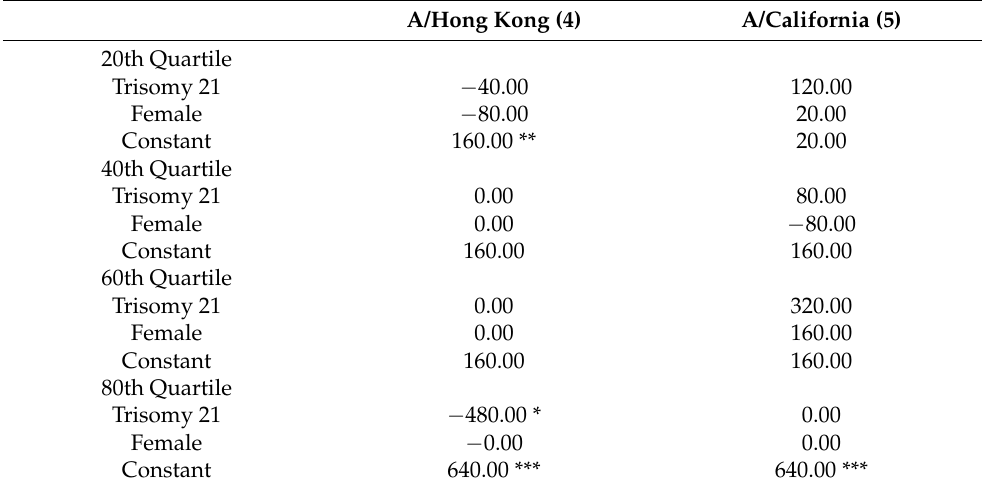
Table 3. Quartile Regression on the effects of T21 on Antibody